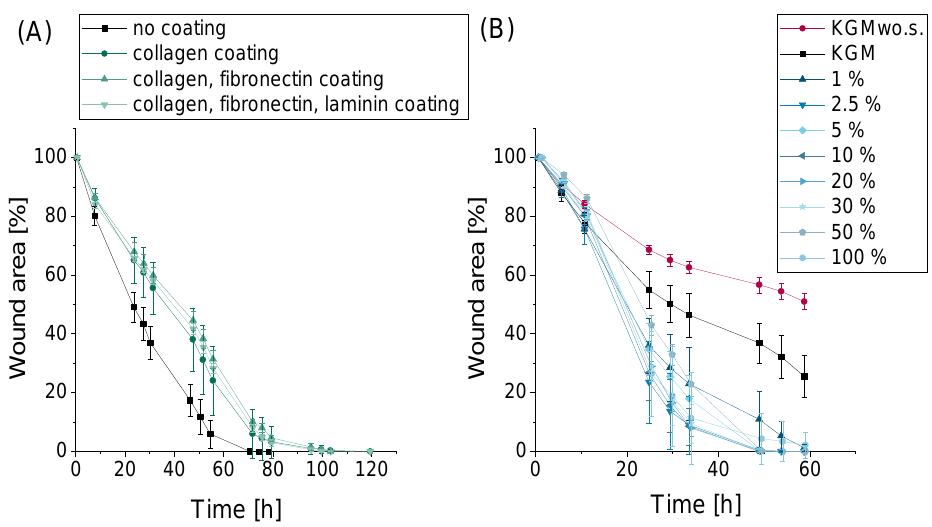
Figure 1. DED wound healing model: ( A ) influence of coating material combinations with collagen, fibronectin and laminin on wound closure in keratinocyte growth medium (KGM); 3 – 4 wells per sample were analyzed (n well = 3 – 4); 6 pictures of the wound area were taken per well (n picture = 6), mean ± standard deviation (SD); ( B ) different serum concentrations in keratinocyte growth medium without supplements (KGMwo.s.) (n well = 3 – 4, n picture = 6, mean ± SD).